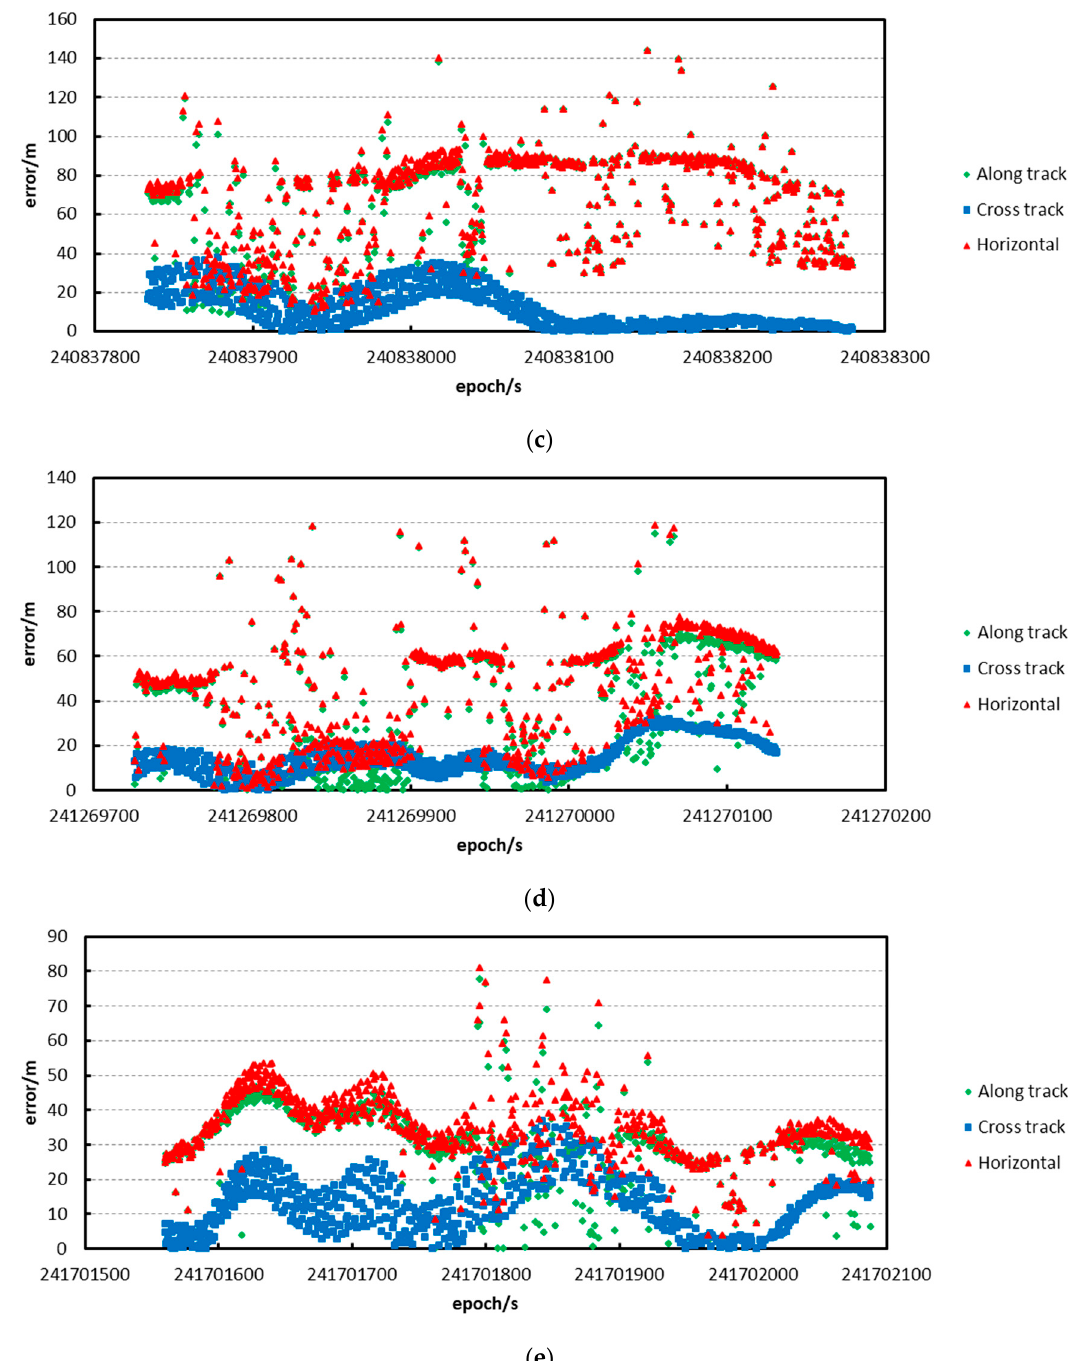
Figure 9. Prediction location error verified by the first method. The prediction error distribution of the test on: ( a ) 9 August; ( b ) 14 August; ( c ) 19 August; ( d ) 24 August; and ( e ) 29 August.